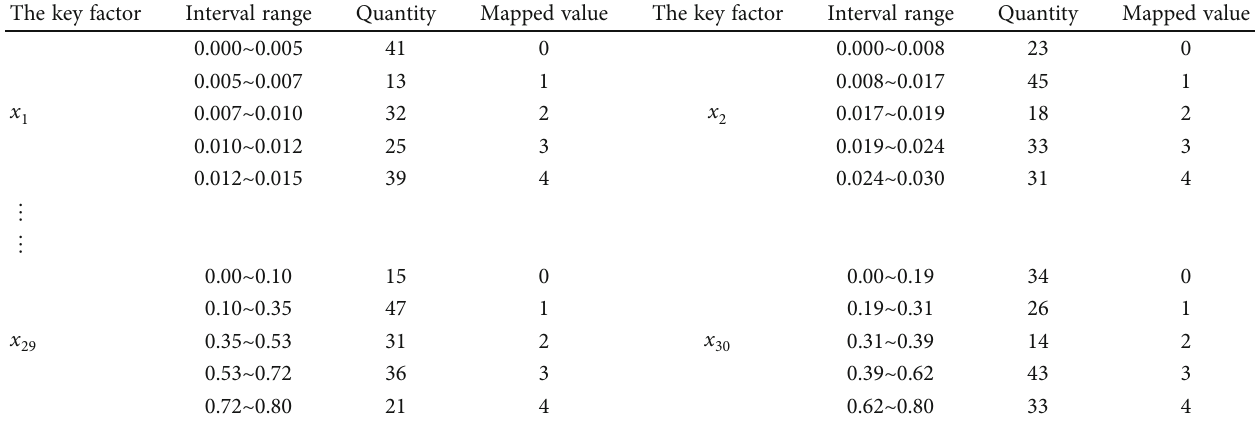
Table 19: Discretization results of multivalue continuous attributes.